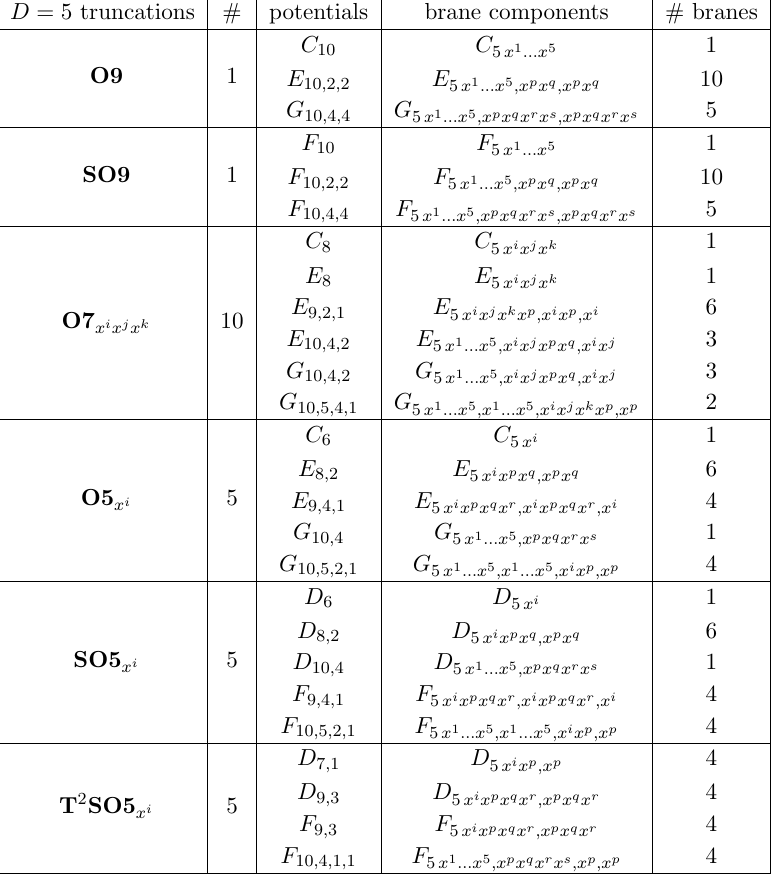
Table 8 . The Z 2 truncations of the maximal theory in D =